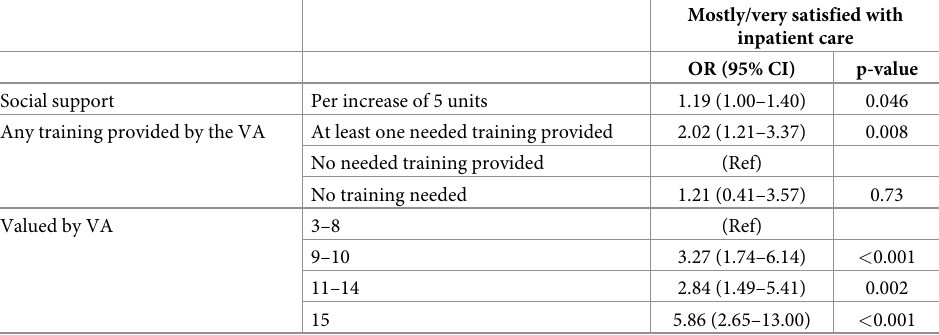
Table 3. Associations between addressable factors and satisfaction with inpatient care in a multivariable logistic regression model a .